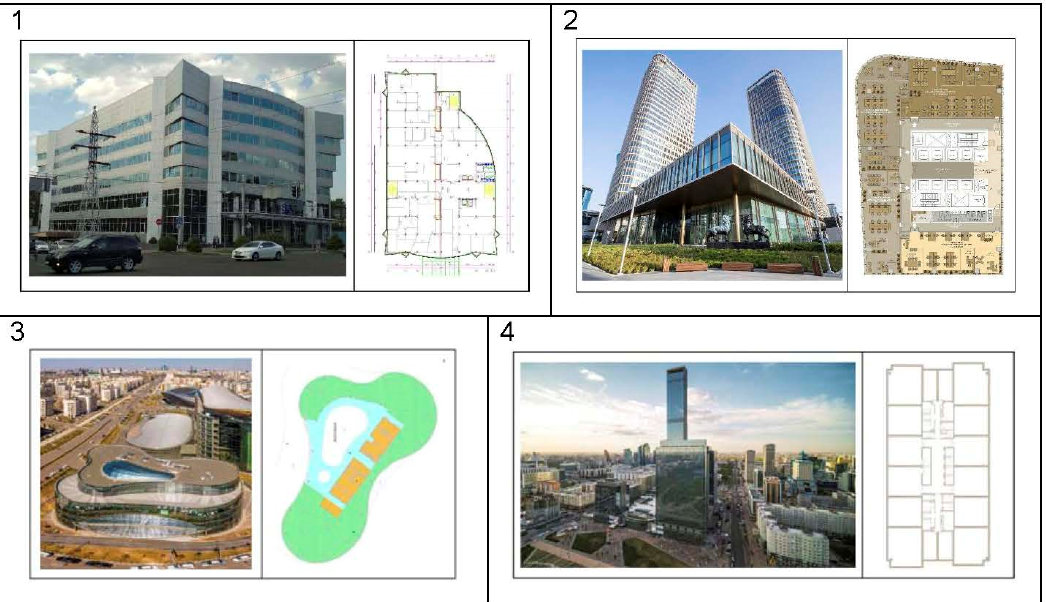
Figure 8. Kazakhstan’s business centers of the early 21st century: ( 1 ) the SAT, Almaty, 2006 [100]; ( 2 ) the TALAN TOWERS, Astana, 2017 [101]; ( 3 ) the CONGRESS OFFICE, Astana, 2016 [102]; and ( 4 ) the ABU DHABI PLAZA, Astana, 2022 [103].